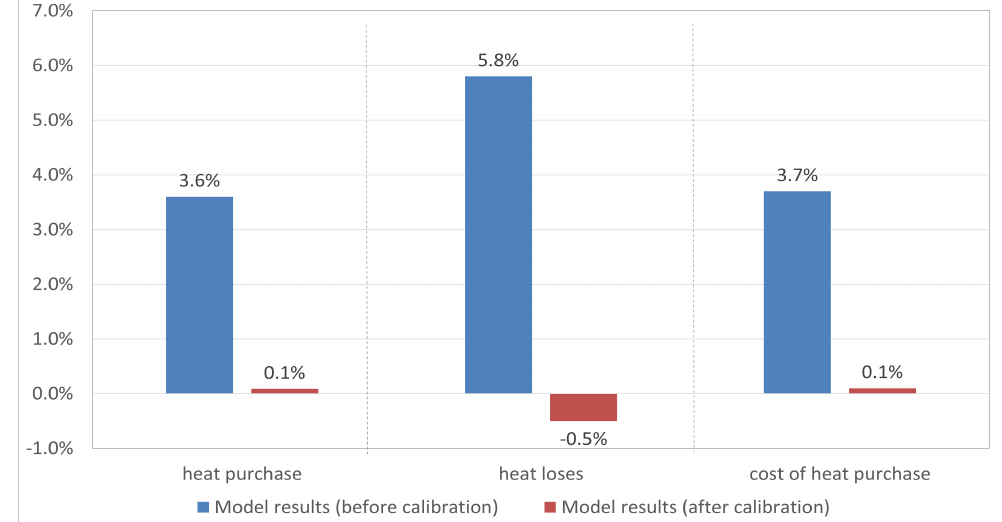
Figure 3. Comparison of the model results and the real system data—heat purchase, losses, total costs of heat purchase %.